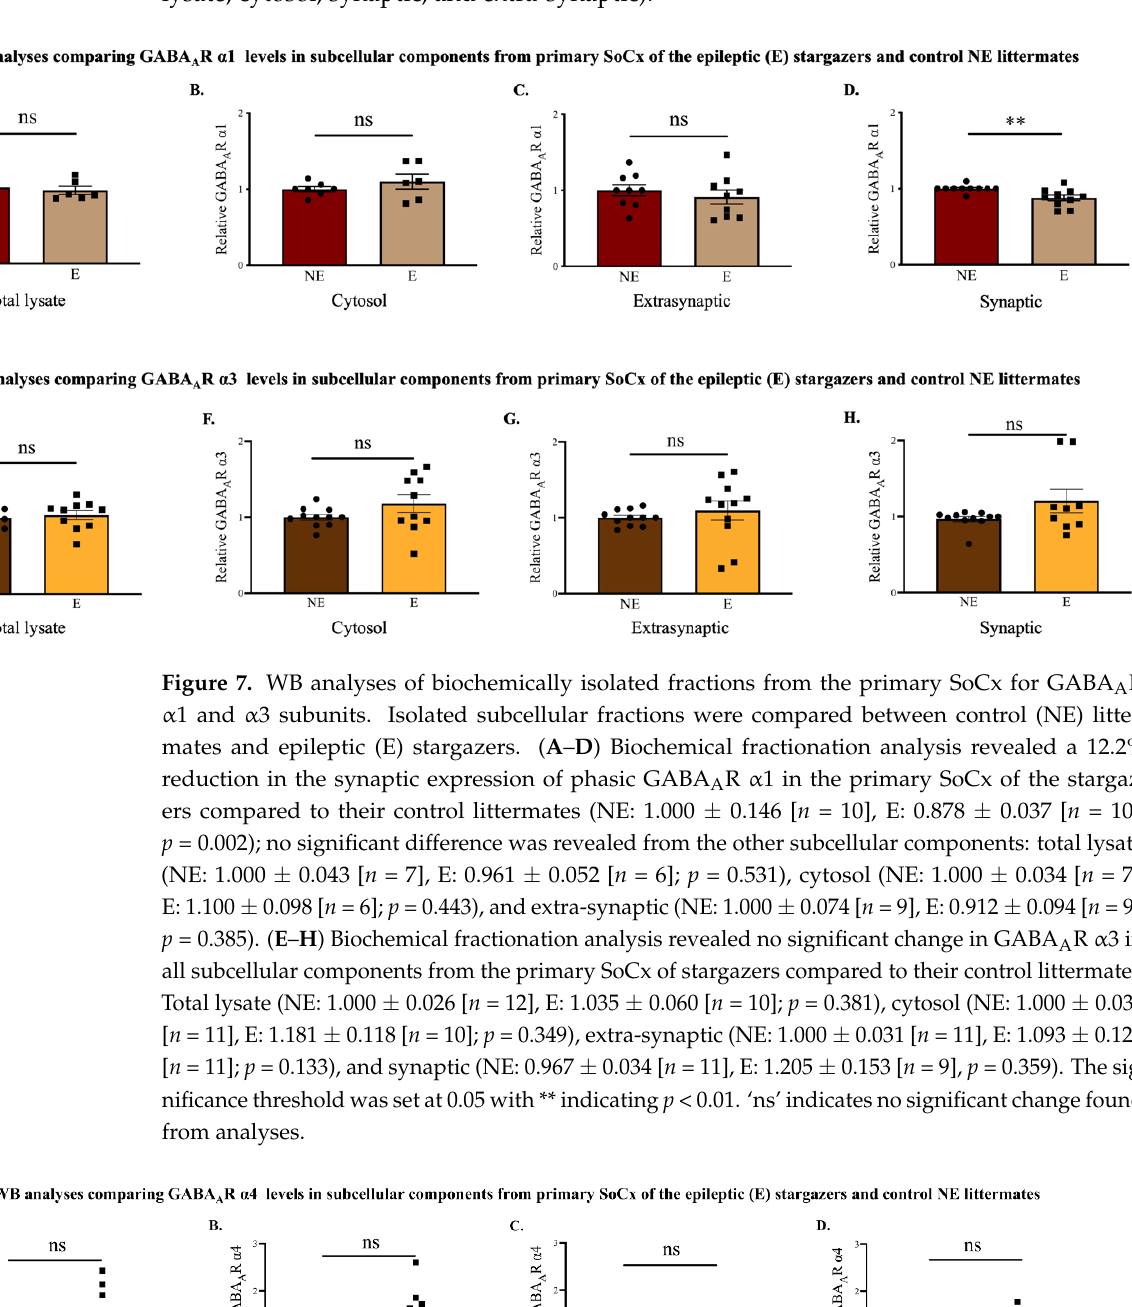
α 5 (Figure 8E–H), or δ (Figure 8I–L) subunit levels in all the sub-cellular fractions (total lysate, cytosol, synaptic, and extra-synaptic).